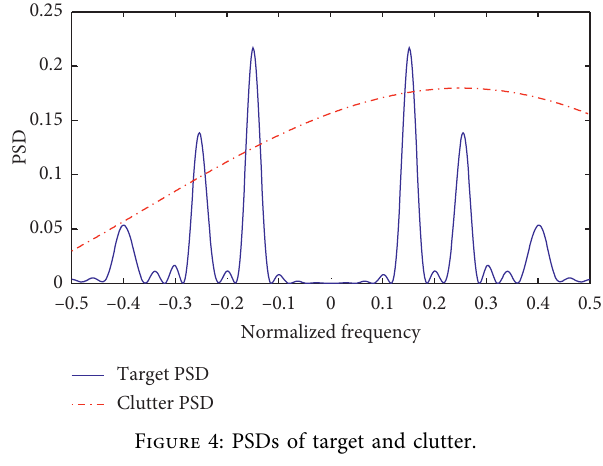
Figure 4: PSDs of target and clutter.